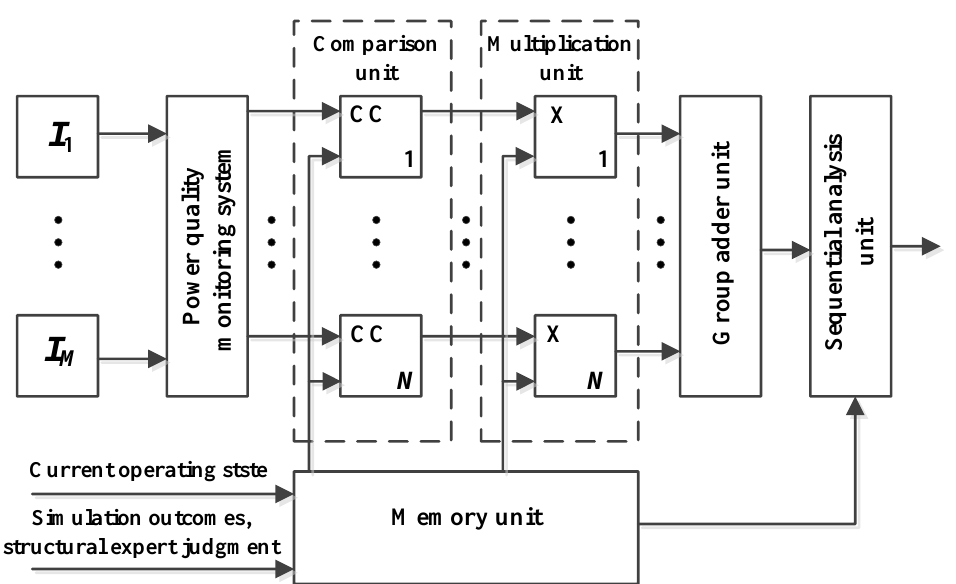
Figure 4. Structural diagram of the device that implements the sampling-based monitoring procedure of the generalized PQP.